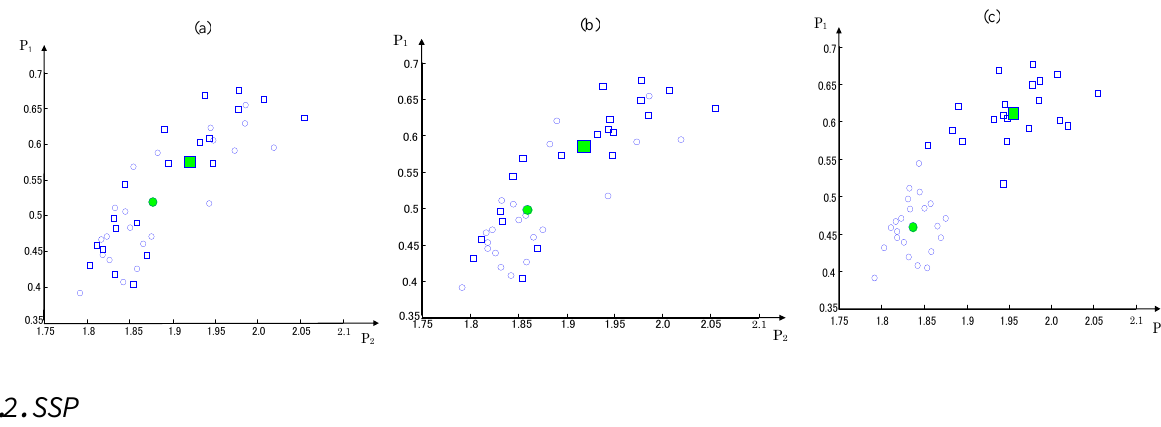
Figure 2. Changes in the clustering centers: ( a ) at the start of the ACO, ( b ) after 100 iterations and ( c ) after 200 iterations. The symbols ○ and □ express the value samples of the SPs in the normal and roller defect states, respectively, and the large symbols ■ and ● represent their respective clustering